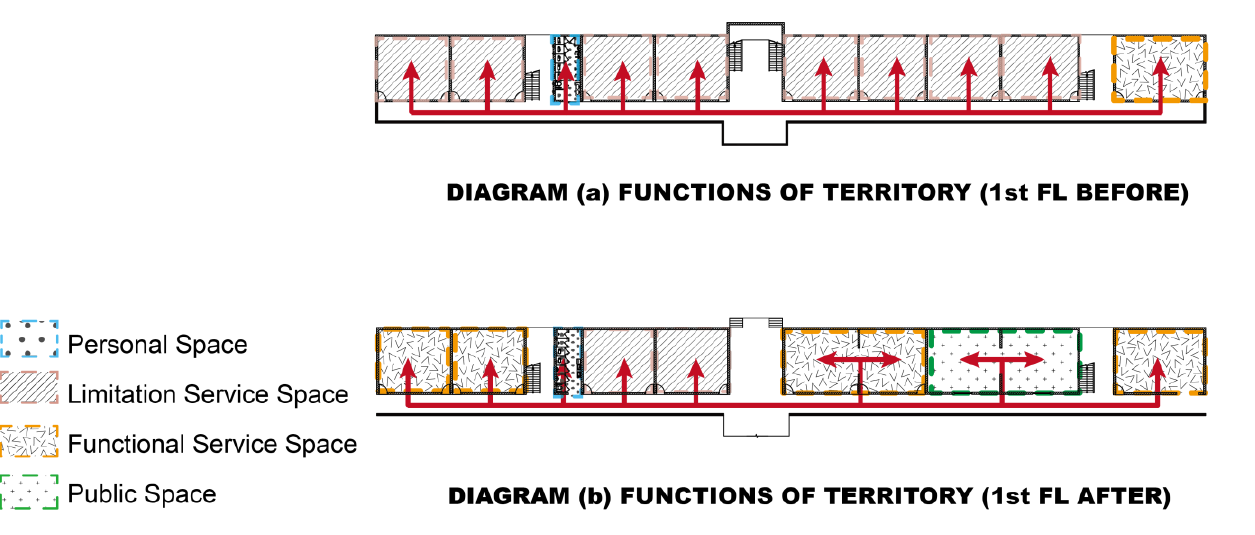
Figure 14. Pingtung Education Innovation Unit Territory Order Diagram: Second Floor Plans. ( a ) Second Floor Plan Before Redesign. ( b ) Second Floor Plan After Redesign.